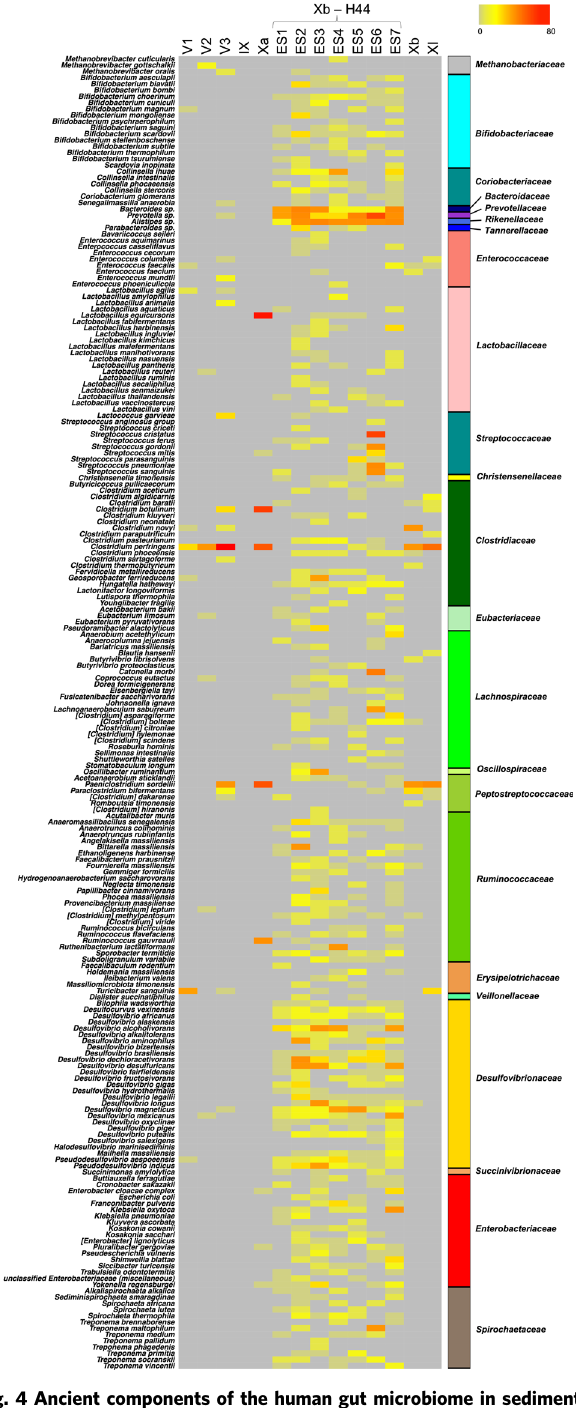
Fig. 4 Ancient components of the human gut microbiome in sediment samples from El Salt. The heat map shows the hit number distribution across sediment samples from the different stratigraphic units. Only ancient bacterial species with ≥ 2 hits in at least one sample were kept. See also Supplementary Data host-derived molecules and immune system) 46 . According to our fi ndings, 210 bacterial species belonging to hominid- associated gut microbiome families, as listed above, are represented in the aDNA from El Salt SU IX, X and XI, with the highest detection rate in samples from SU X and, parti- cularly, in ES1 to ES7 (Fig. 4), for which a human-like host origin had been previously suggested 25 . In Supplementary